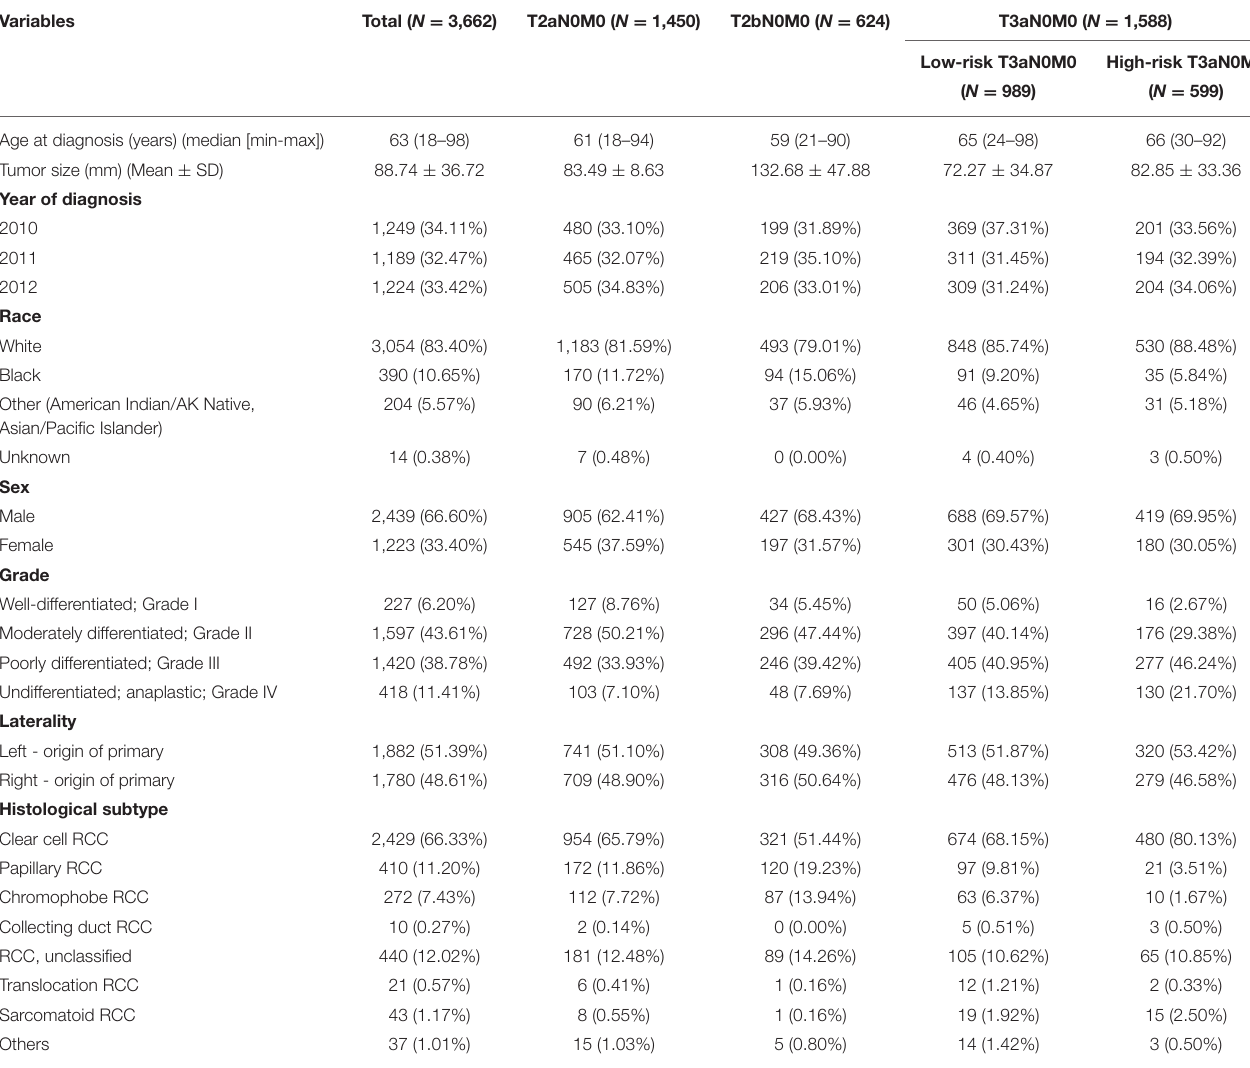
TABLE 1 | Clinical and tumor characteristics of the 3,662 analyzed enrollees.